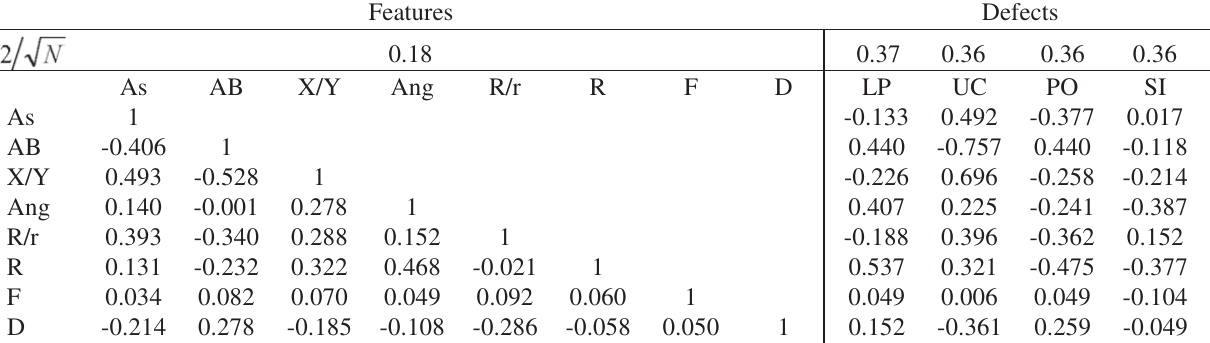
Table 1. Matrix of correlation with the correlated